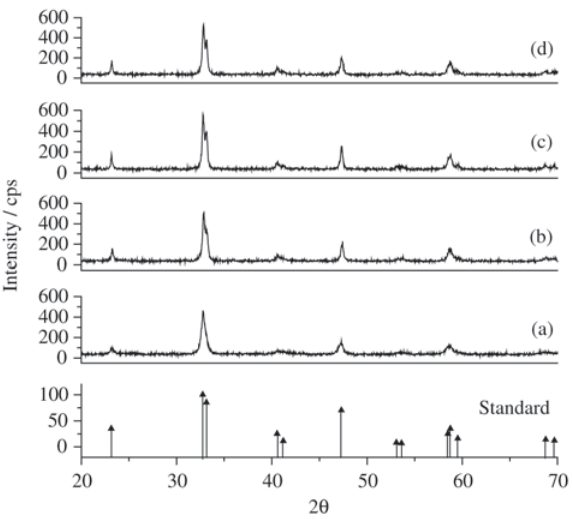
Figure 4. XRD diagrams of LaNiO